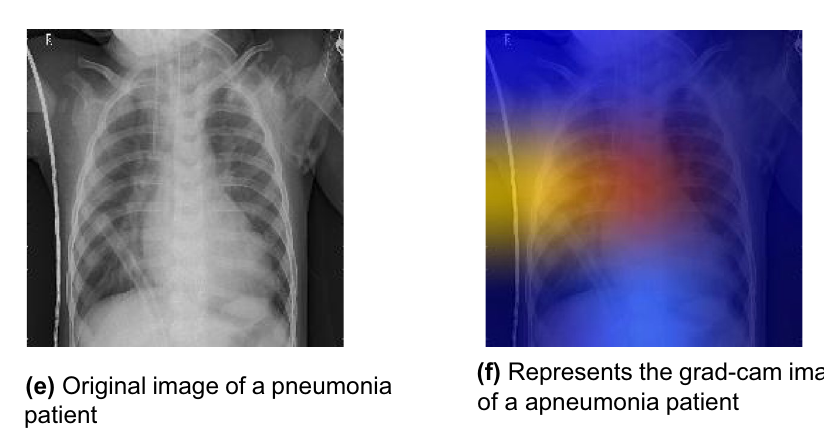
Figure 7. Grad-cam images along with original chest X-ray images for the base classifier 2 trained on the Dataset-1. Images are taken from the public datasets found in 51,52